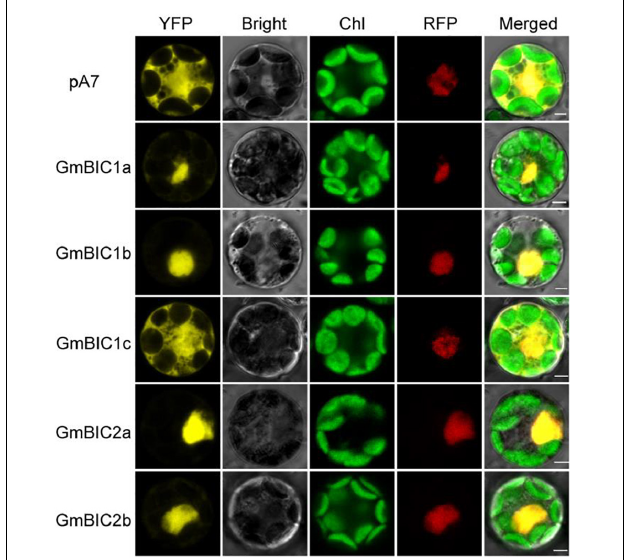
FIGURE 2 | Subcellular localization of recombinant GmBIC proteins in soybean mesophyll protoplasts. Fluorescence image of subcellular localization of GmBICs-YFP proteins in mesophyll protoplasts prepared from the leaves of 12-day-old Williams 82 grown under short-day conditions. The GmMYB29-RFP fusion protein was used as the nuclear marker. pA7-YFP empty vector was used as a control. Scale bars = 2 µ